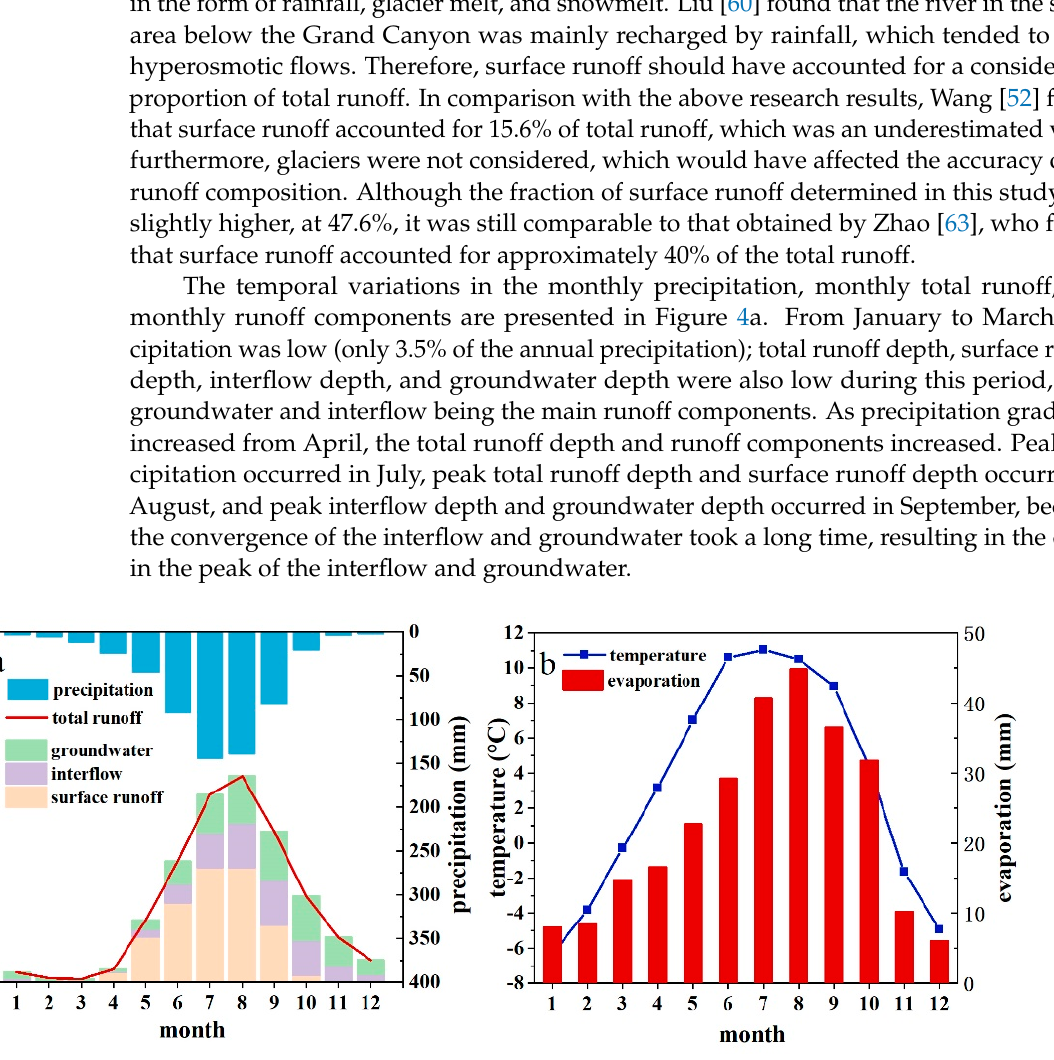
Figure 4. Temporal variation in ( a ) the monthly precipitation and total runoff and runoff component; and ( b ) temperature and